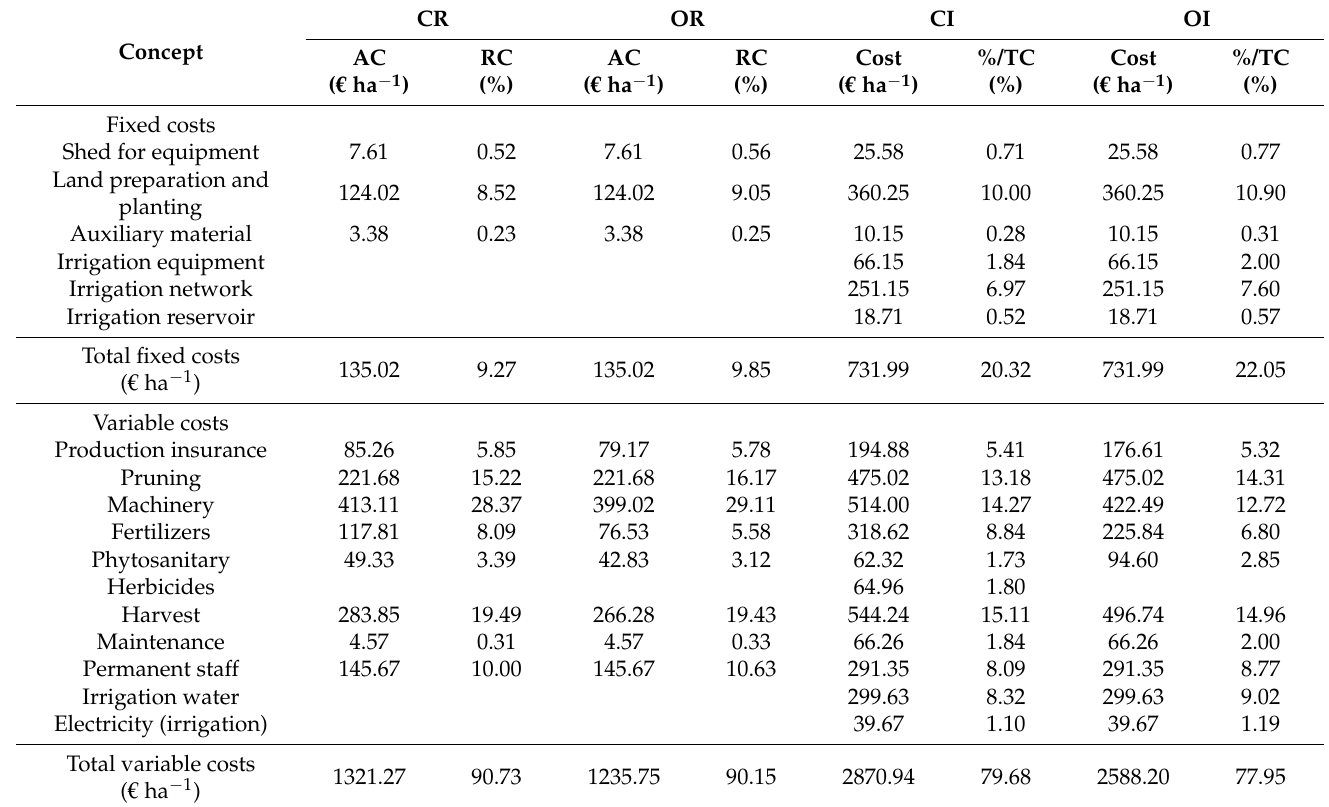
Table 4. Cost structure of the four vineyard